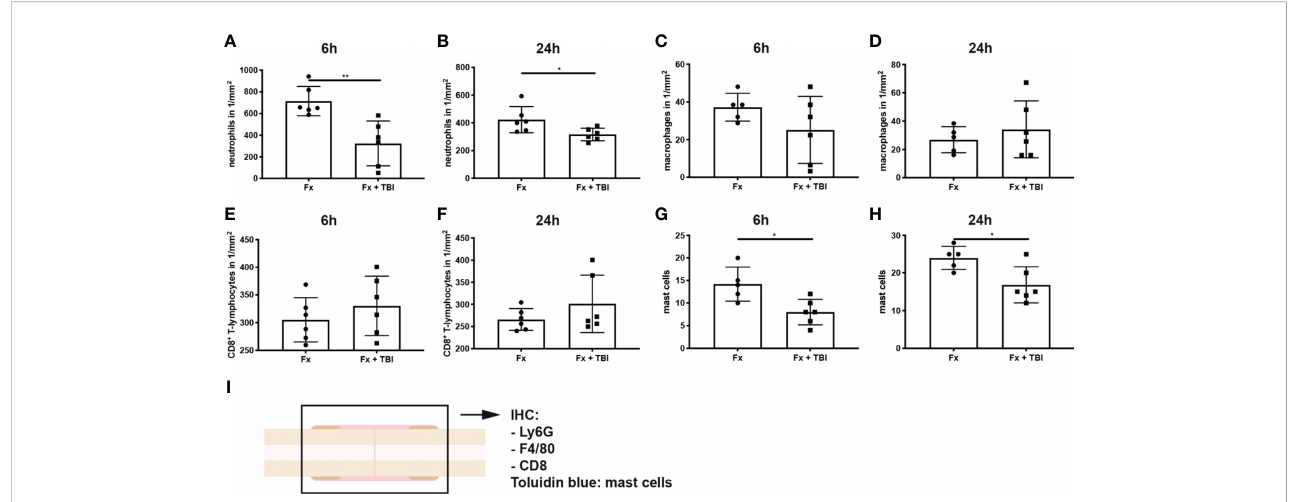
FIGURE 3 Immune cell populations in the fracture hematoma. Longitudinal sections of the fracture bones were cut and stained for immune cell markers. (A) Ly6G + neutrophil numbers at 6h and (B) 24h after injury. (C) F4/80 + macrophage numbers at 6h and (D) 24h after injury. (E) CD8 + T-lymphocyte numbers at 6h and (F) 24h after injury. (G) Mast cell numbers were determined in Toluidin blue staining at 6h and (H) 24h after injury. (I) Experimental design. * indicates p-value below 0.05 for comparison between Fx and Fx+TBI; ** indicates p-value below 0.01 for comparison between Fx and Fx+TBI.